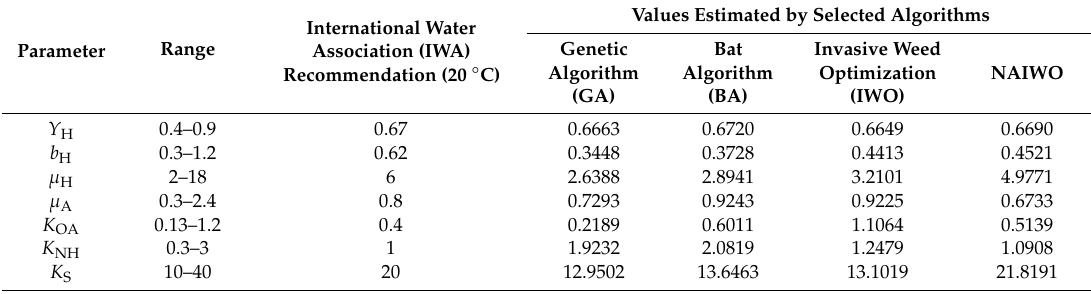
Table 2. Estimated results of seven parameters of ASM1 for